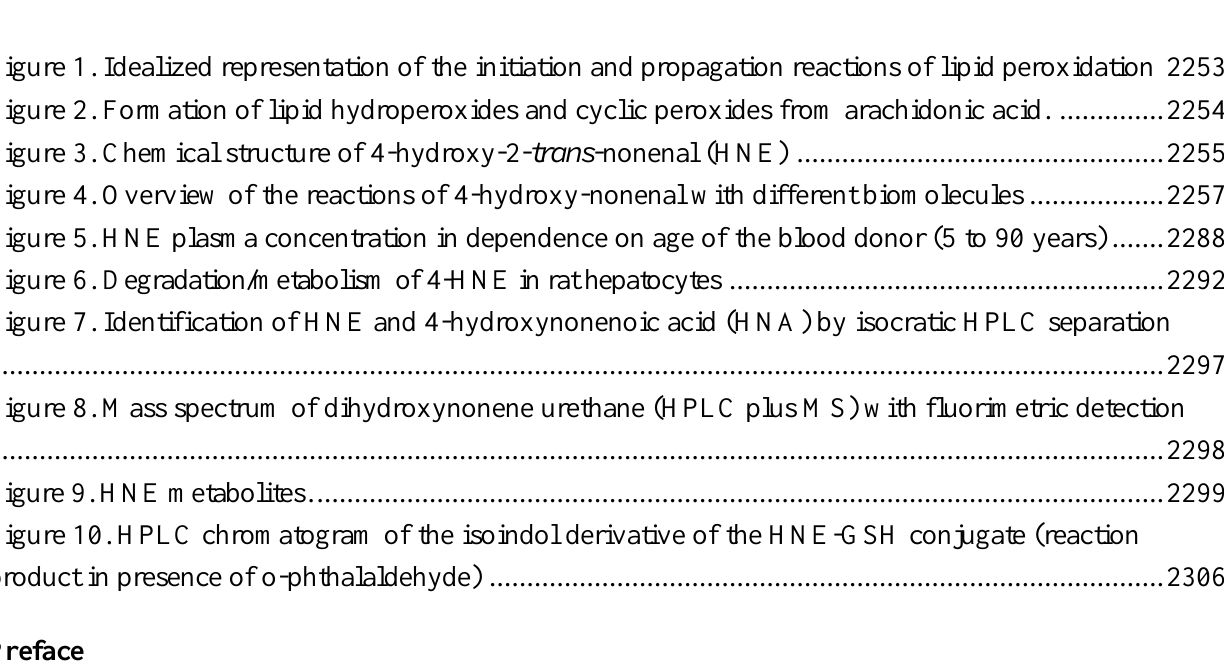
Table 2. Maximal velocity of total HNE degradation in cells, subcellular organelles, and perfused organs Table 3. Primary HNE metabolites in different cells and tissues after the addition of 100 μM HNE to